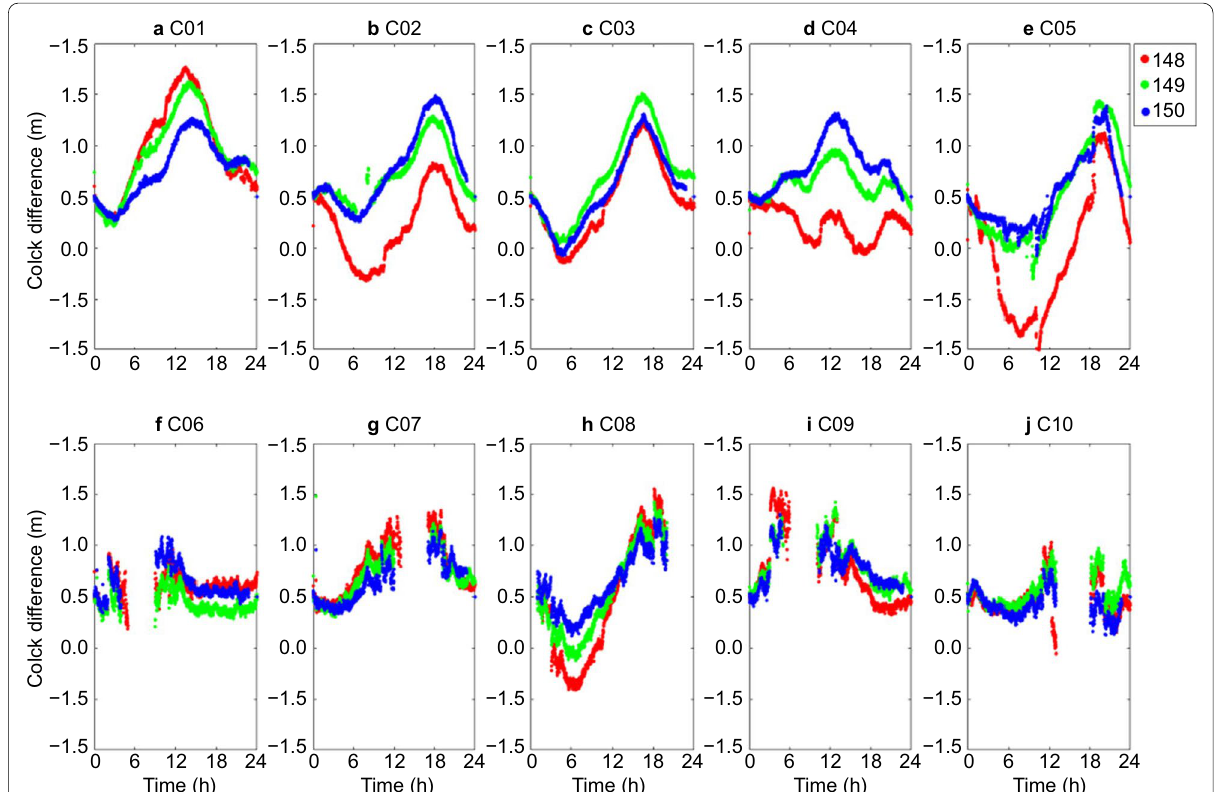
Fig. 3 Satellite clock differences between ODTS and TWSTFT techniques used for the period of DOY 148–150 in 2017, where each daily time series is shifted with a clock difference at the first epoch re-aligned to 0. The value in the legend box shows the day of the